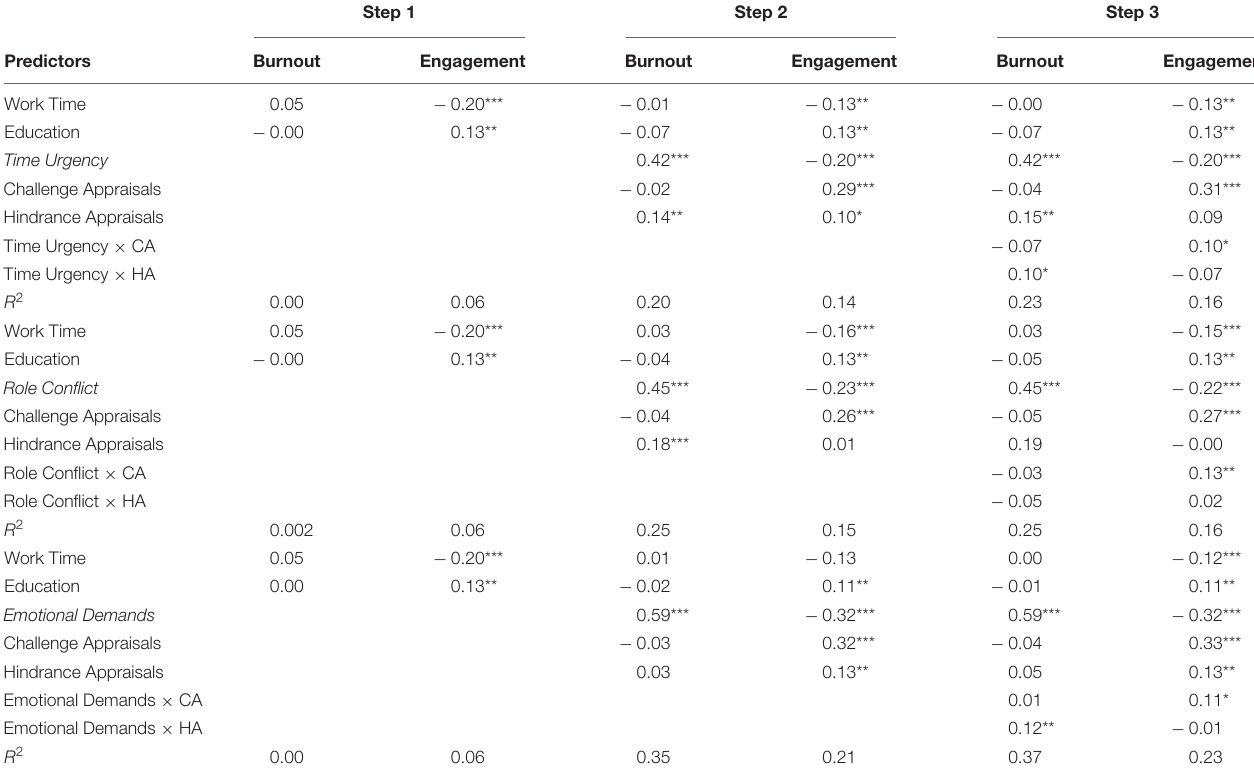
TABLE 3 | Regression results for the moderation of appraisals on the relationships between job demands and work engagement/Burnout in Study 1. Step 1 Step 2